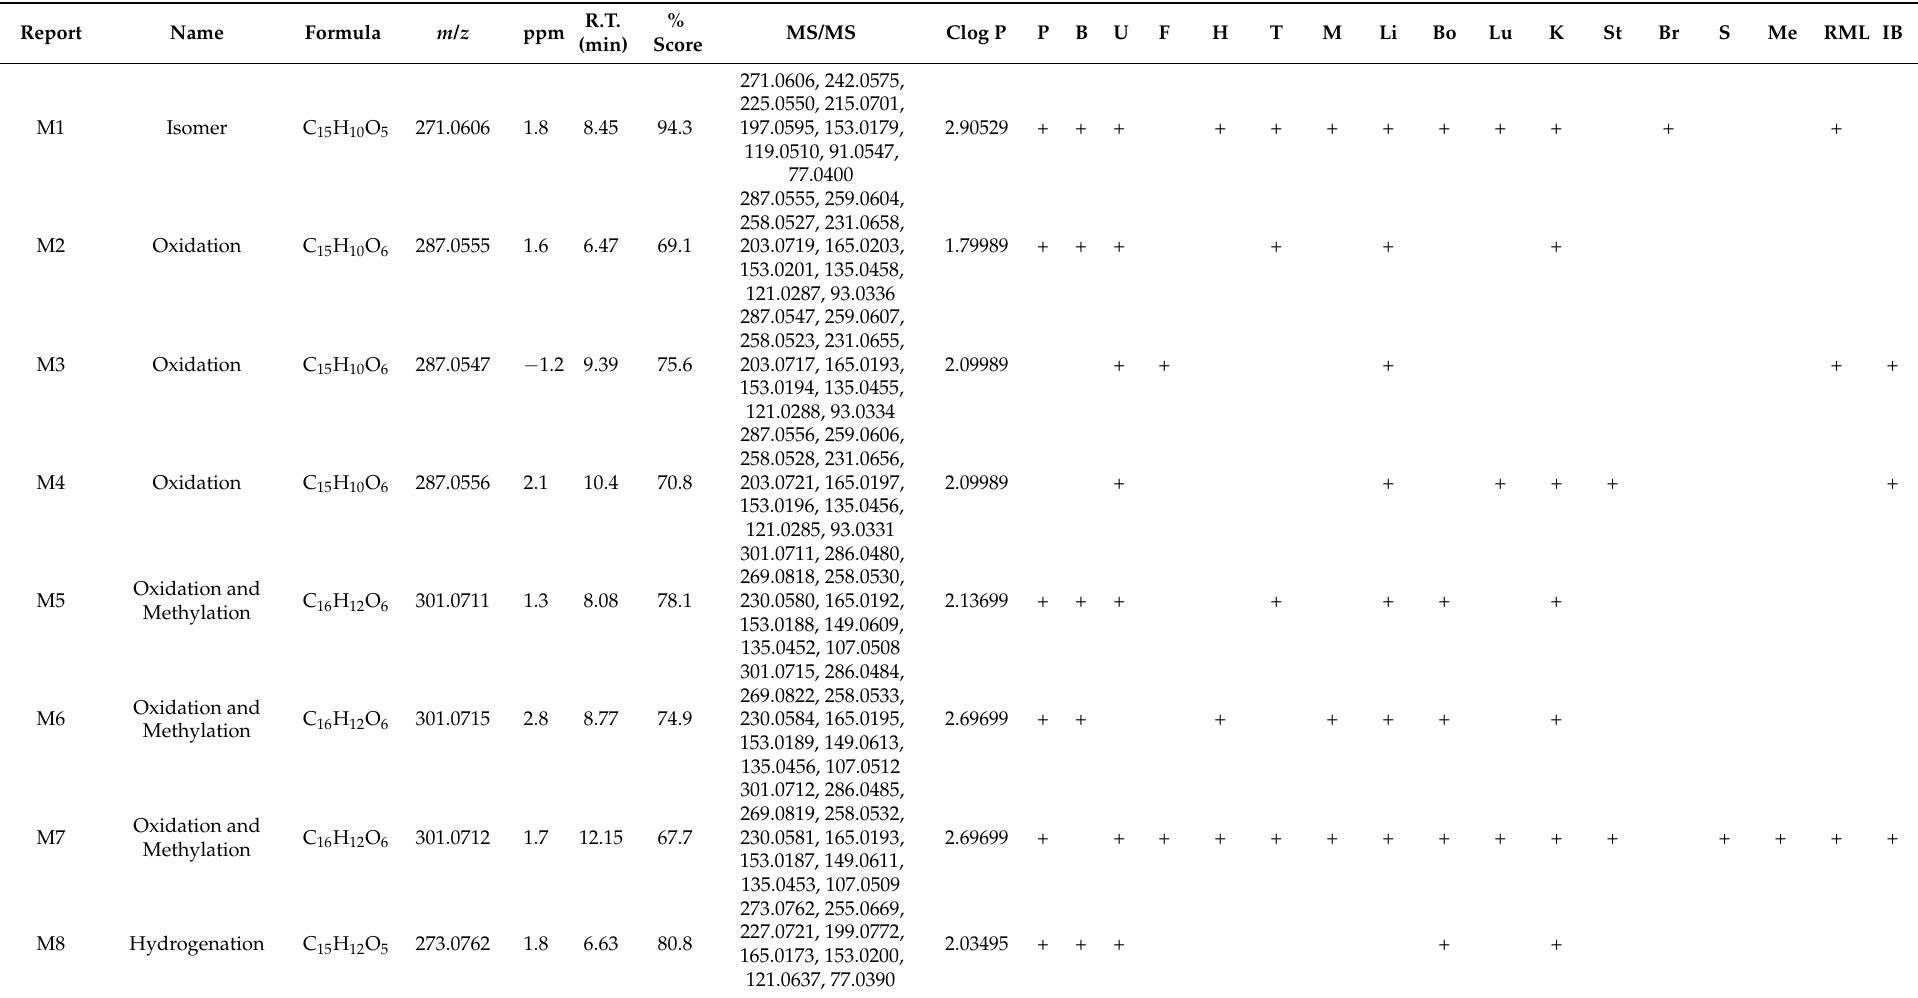
Table 2. Summary of phase I and phase II metabolites of galangin in rat liver microsomes, intestinal bacteria, blood, urine, bile, feces, and tissue